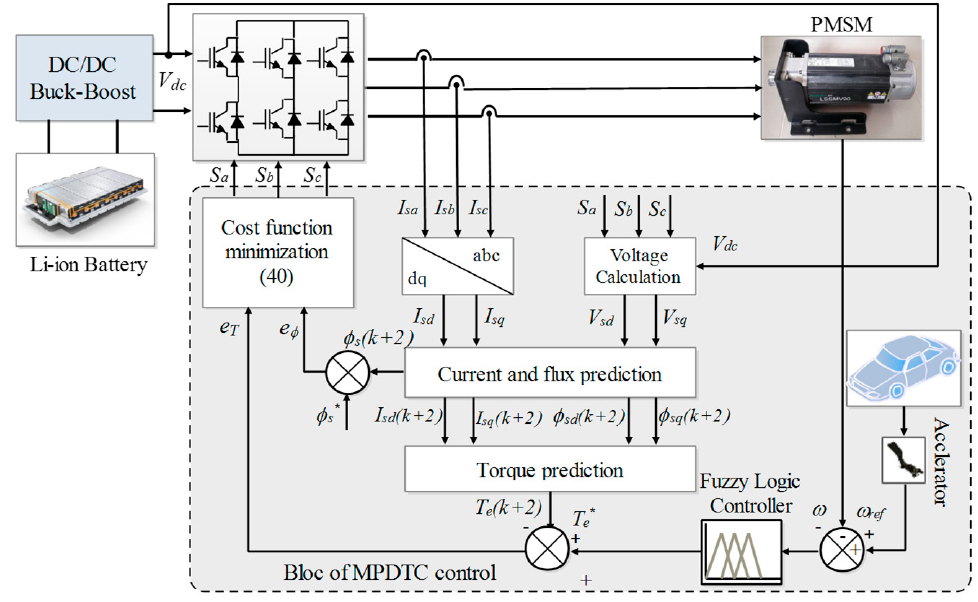
Figure 10. Block diagram of the proposed MPDTC technique for an PMSM in EV system.